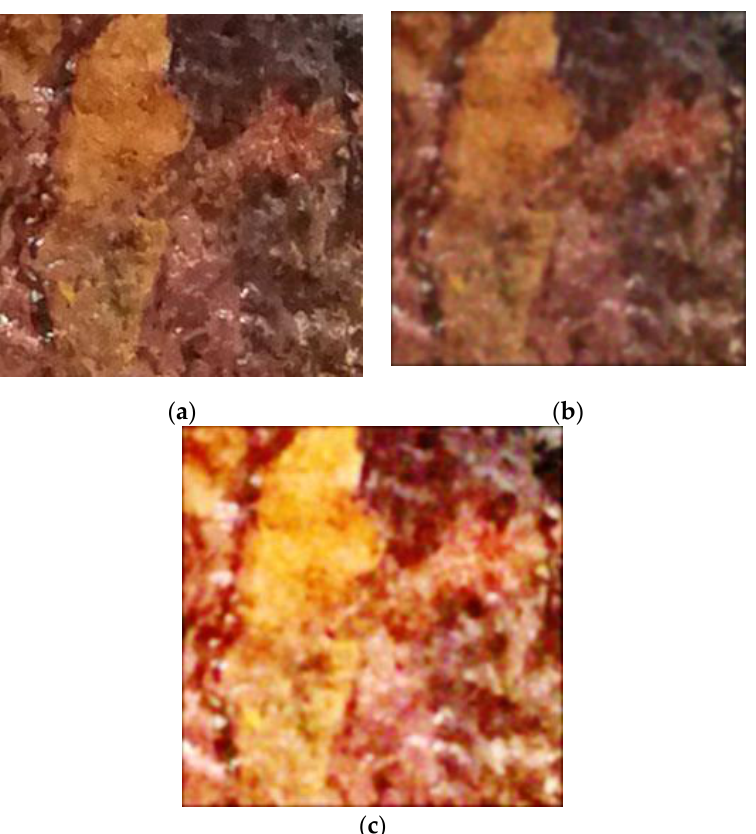
Figure 2. Preprocessing of the collected images: ( a ) image normalization, ( b ) Gaussian filter denoising, ( c ) histogram equalization.